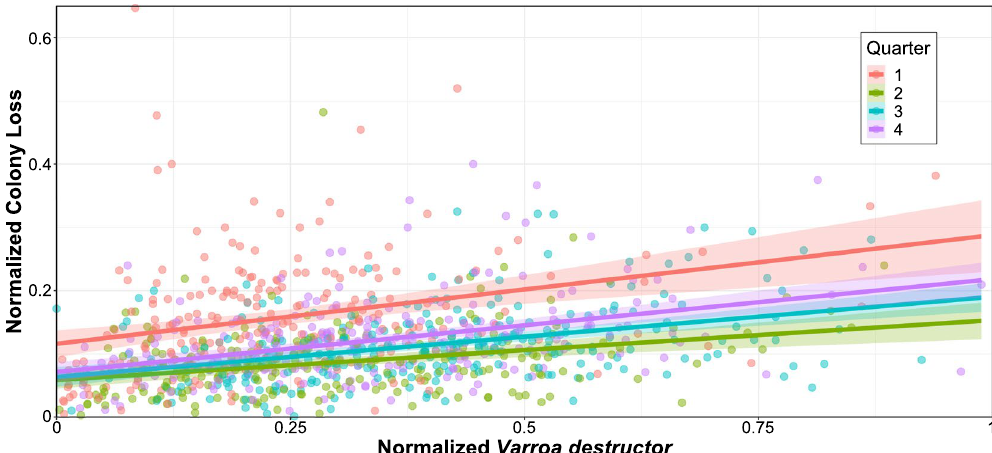
Figure 4. Scatter plot of normalized honey bee ( Apis mellifera ) colony loss (number of lost colonies over the maximum number of colonies) against normalized Varroa destructor presence (number of colonies affected by V. destructor over the maximum number of colonies) for each state and each quarter of 2015–2021 (the first quarter being January-March). Points are color-coded by quarter, and ordinary least squares fits (with corresponding standard error bands based on a 0.95 confidence level) computed by quarter are superimposed to visualize the positive